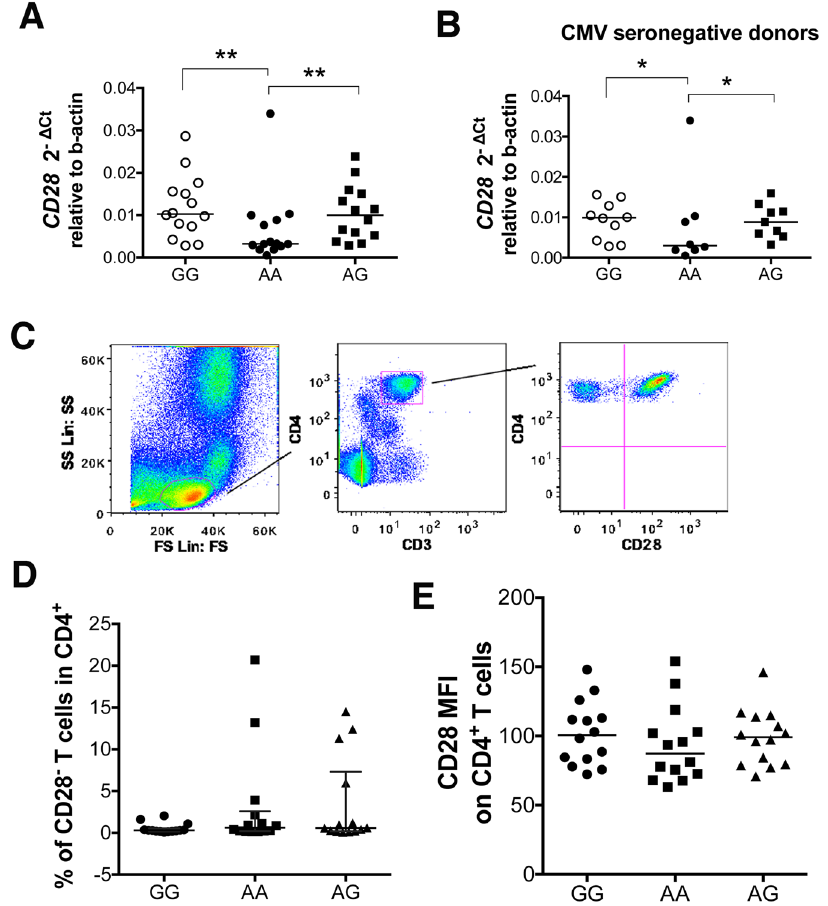
Figure 2. AA subjects show reduced CD28 mRNA expression but similar frequencies of CD4 + CD28 − T cells with GG and AG. ( A ) RNA from freshly isolated peripheral blood mononuclear cells (PBMCs) was extracted, transcribed into cDNA and tested for CD28 mRNA expression in healthy individuals homozygous (AA) or heterozygous (AG) for the PSC risk variant and homozygous for the protective allele (GG) (n = 14 per group). Data are expressed as 2 −Δ Ct relative to beta actin. Lines indicate median values. ** p = 0.002 and ** p = 0.003 with Mann Whitney U test after exclusion of the outlier detected in the AA group by Grubbs test. ( B ) CD28 mRNA expression in total PBMCs in CMV seronegative donors. Data are expressed as 2 −Δ Ct relative to beta actin. AA and AG healthy individuals homozygotes and heterozygotes for the PSC risk variant and GG homozygotes for the protective allele. Lines indicate median values. * p = 0.02 and * p = 0.03 with Mann Whitney U test after exclusion of the outlier detected in the AA group by Grubbs test. ( C ) Representative flow cytometry plots showing the gating strategy to define CD4 + CD28 − T cells in PBMCs. CD3 + CD4 + cells were selected after duplet exclusion and CD28 expression was studied in the CD4 + population. ( D ) Data show the proportion of CD4 + T cells that have lost CD28 expression. Line indicates median with interquartile range. ( E ) CD28 median fluorescence intensity (MFI) across genotypes. Line indicates median